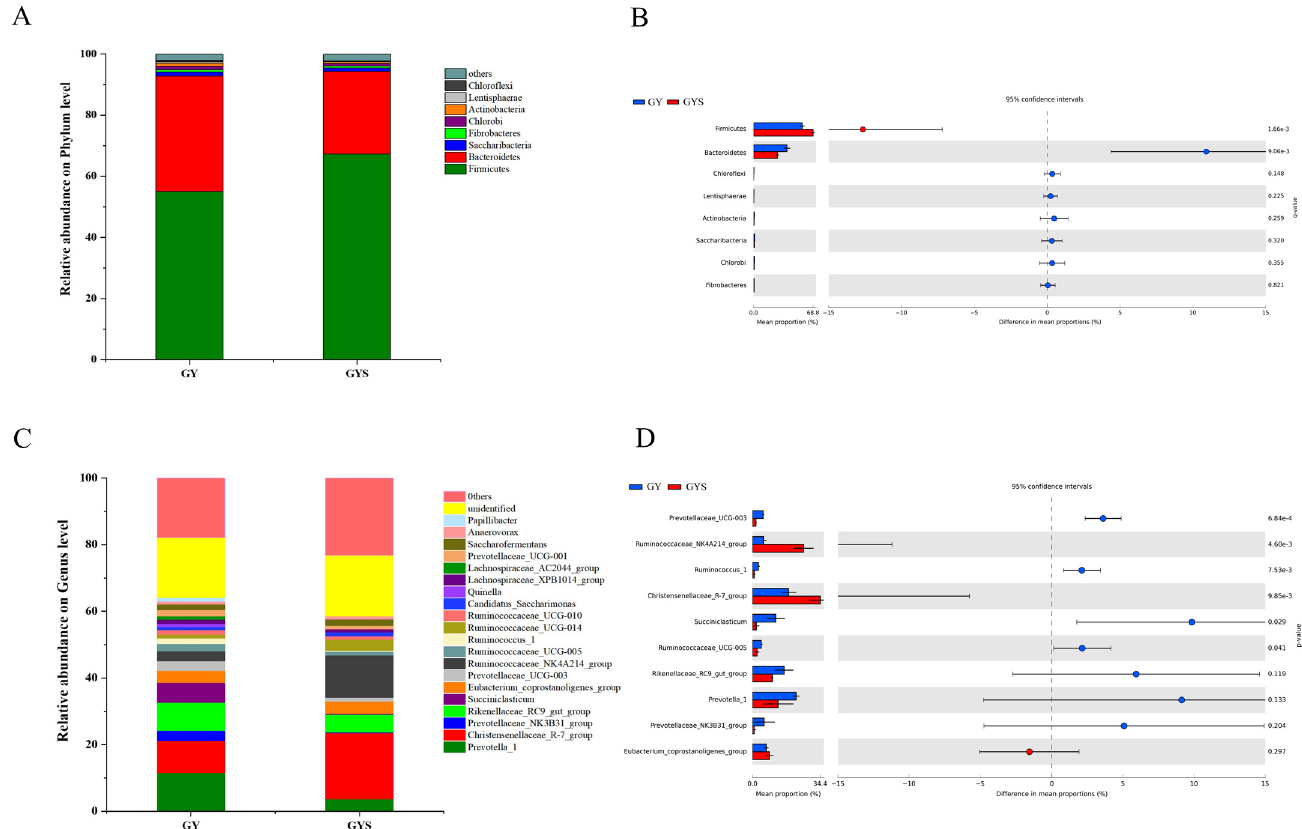
Figure 2. Classification of the bacterial community composition from different feed types. ( A ) Relative abundance of bacterial community at the phylum level. ( B ) Statistical comparison of the dominant phyla in the GY and GYS groups. ( C ) Relative abundance of bacterial community at the genus level. ( D ) Statistical comparison of the dominant genera in the GY and GYS groups. Data are shown as mean ± SEM.